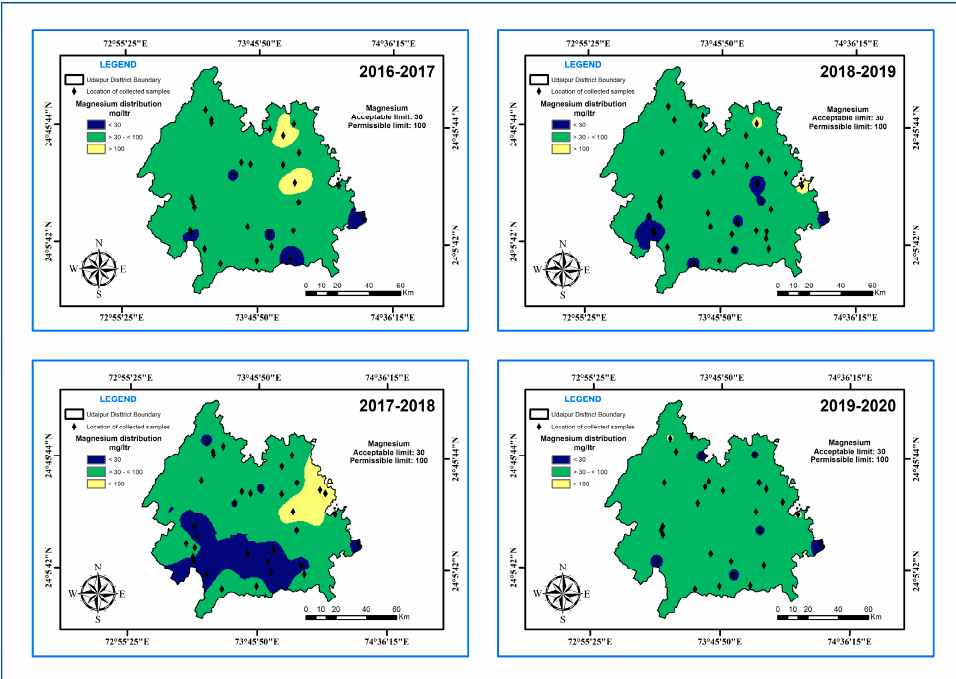
Figure 21. The changing distribution of magnesium from 2016–2018 in the study area.